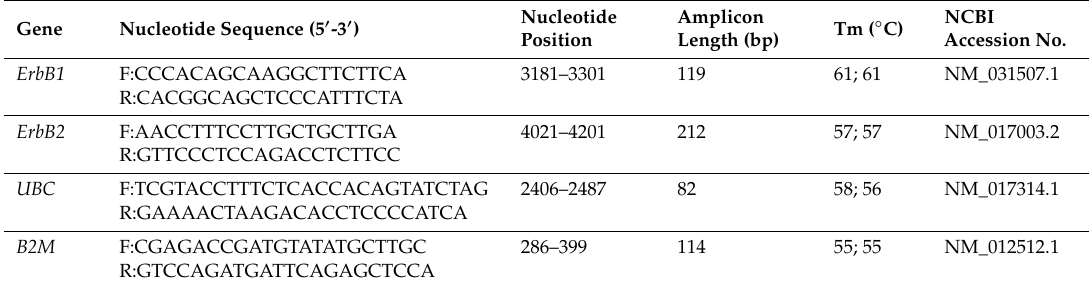
Table 1. Primer sequences used in real-time polymerase chain reaction